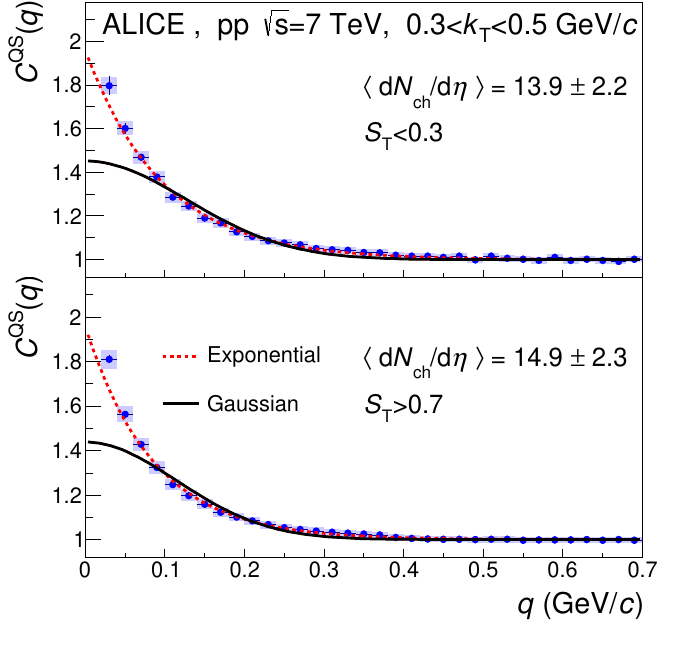
Figure 3 . Comparison of exponential and Gaussian (cid:12)t results for C QS ( q ) functions in spherical and jet-like